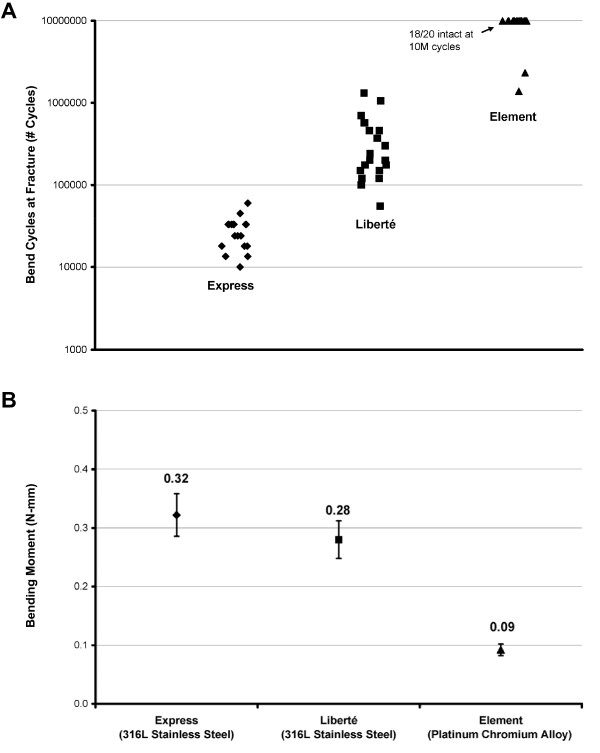
Strength and flexibility of the TAXUS Element stent compared to TAXUS Express and TAXUS Liberté stents. (A) Stent integrity, as measured by an accelerated life test of the bending fatigue of a stent in a simulated overlapped stent configuration, showing number of bend cycles before stent fracture. The test is conducted by mounting one end of a nominally deployed stent to a fixed mandrel while the other end is mounted to a mandrel suspended in a flexible membrane. The membrane mounted end of the stent is translated perpendicular to the longitudinal axis of the stent to impart a repeatable bend in the stent. (B) Conformability - a measure of the torque required to bend the stent to a specific curvature, which is directly related to flexibility of the stent. Lower required bending moment indicates increased flexibility. N = 15 for each stent type. Bars represent ± 1 standard deviation.